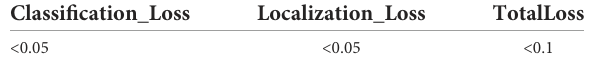
TABLE 3 Inception V2- Coco training loss value.